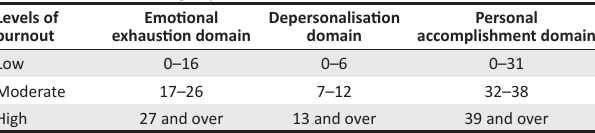
TABLE 1: Burnout scoring key. Levels of burnout